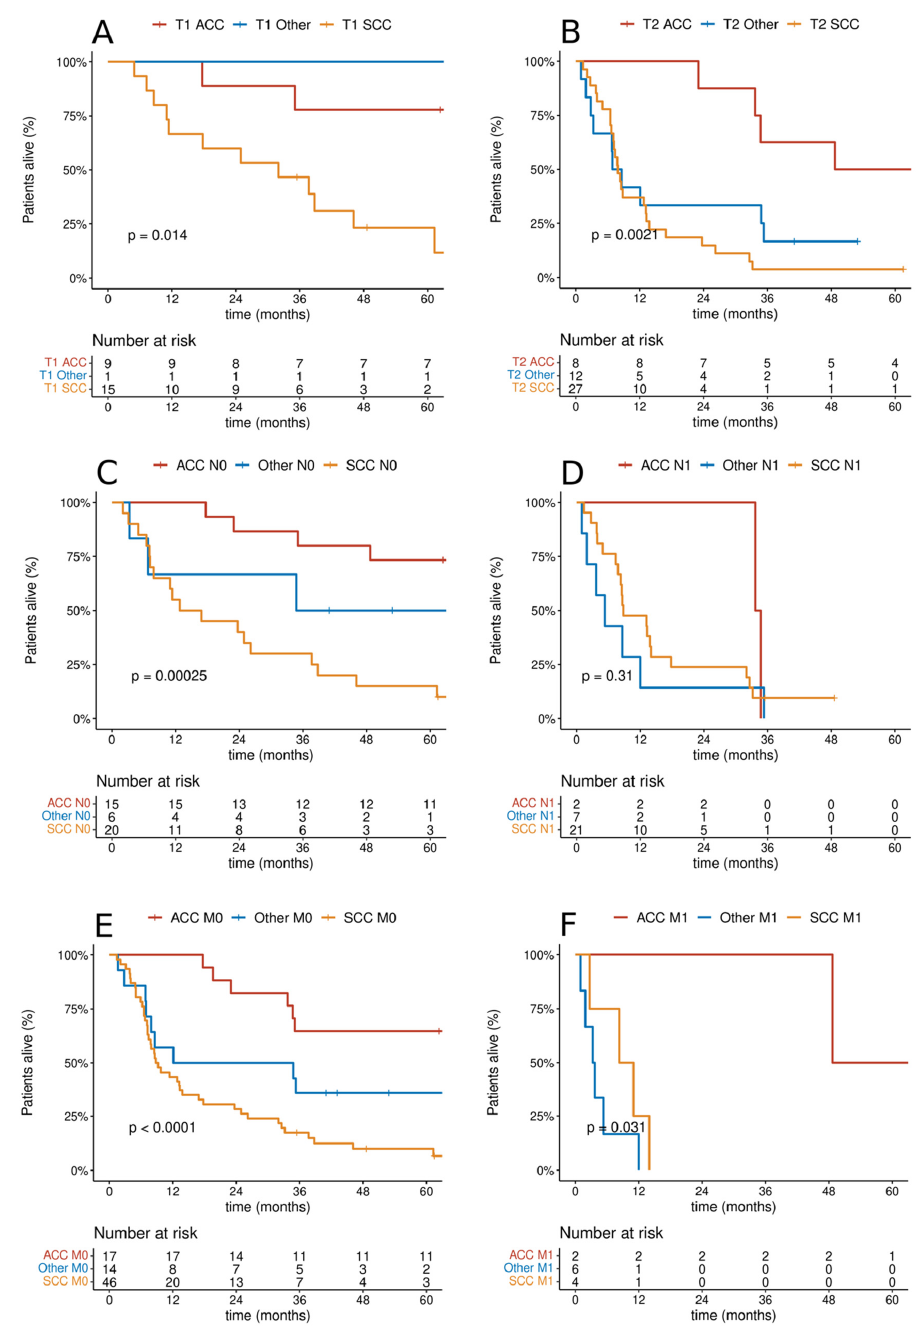
Figure 3. Cumulative probability of overall survival according to histological type by TNM cate-